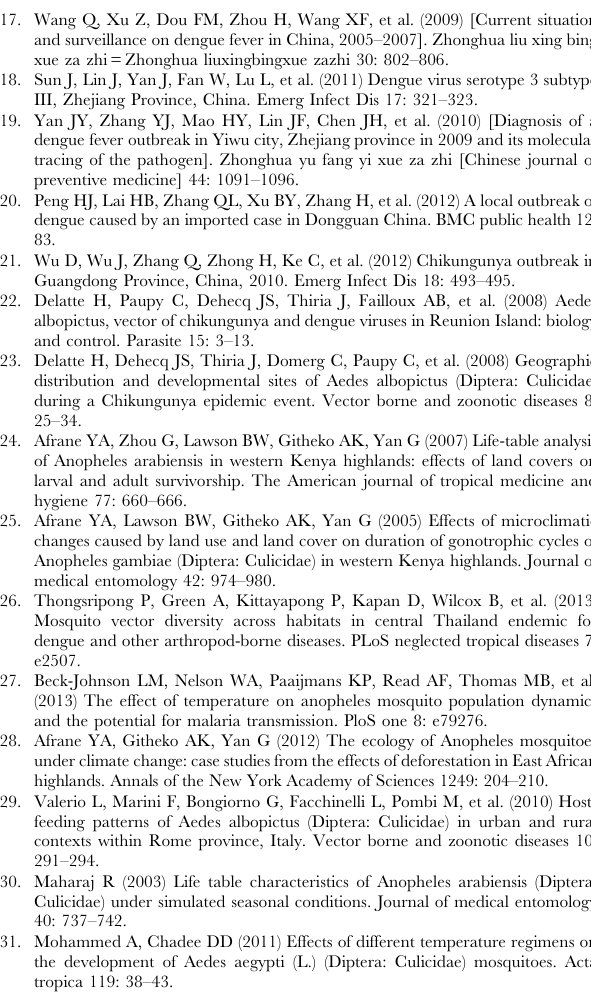
Figure S1 Landscape of study areas in Guangzhou, Guangdong province, China. A and B: Urban; C and D: Suburban; E and F: Rural. Figure S2 Weekly temperature, humidity, and half- month precipitation data in urban, suburban and rural areas in 2013. A: Temperature; B: Relative humidity; C: Precipitation in one half month. A and B: Values are the mean 6 standard error. Figure S3 The most abundant Aedes albopictus breed- ing habitats in the three study sites. Urban area: (1) aquatic plant, (2) plastic bucket, (3) disposable food tin, (4) gutter, (5) tire; suburban area: (6) tire, (7) disposal food tin, (8) clay pottery, (9) plastic bucket, (10) plastic basin; rural area: (11) clay pottery, (12) plastic bucket, (13) disposal food tin, (14) plastic basin, (15) building tool. Table S1 Development of Ae. albopictus larvae. Note: Values are the mean 6 standard deviation. Values in the same column within the same experimental group connected